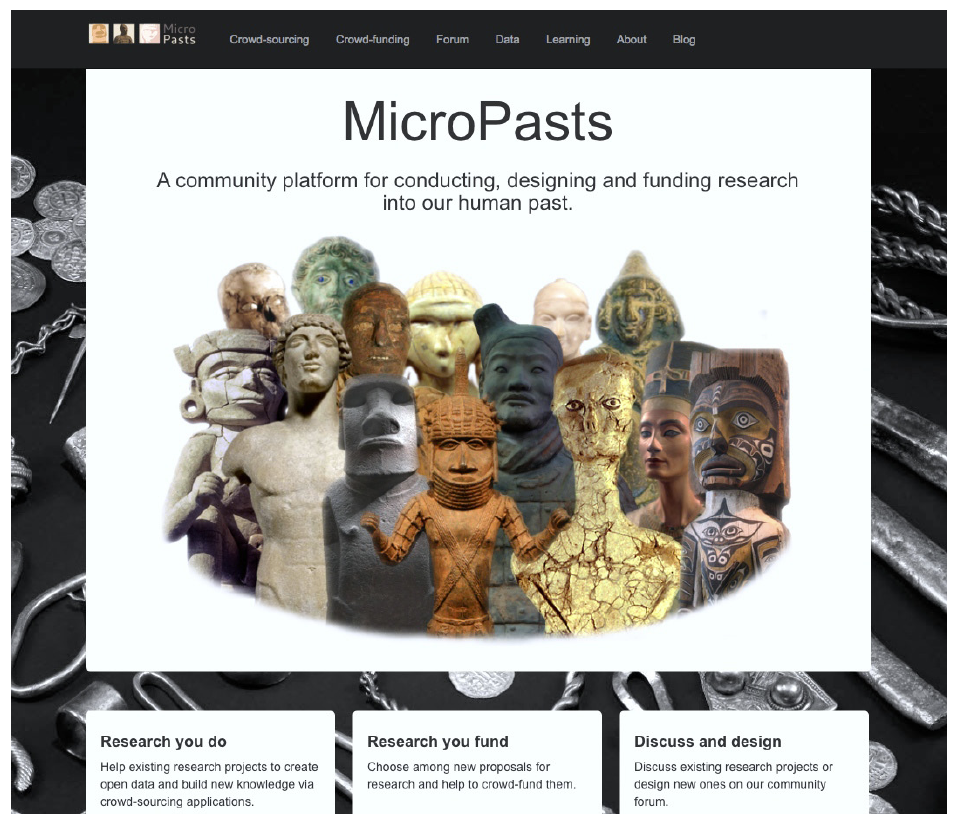
Fig. 1: The homepage of the MicroPasts website